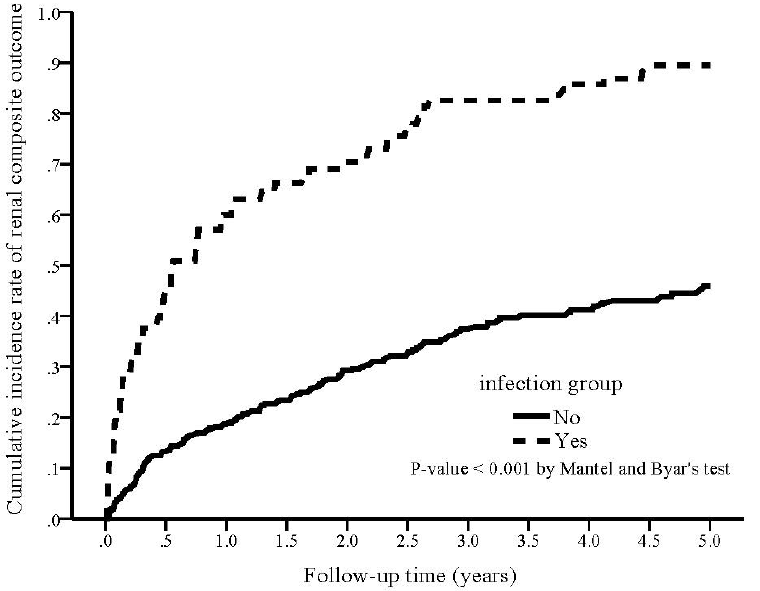
Figure 2. Kaplan–Meier curve of the cumulative incidence rate of renal composite outcome for patients with and without infection (Mantel and Byar’s test, p < 0.001).